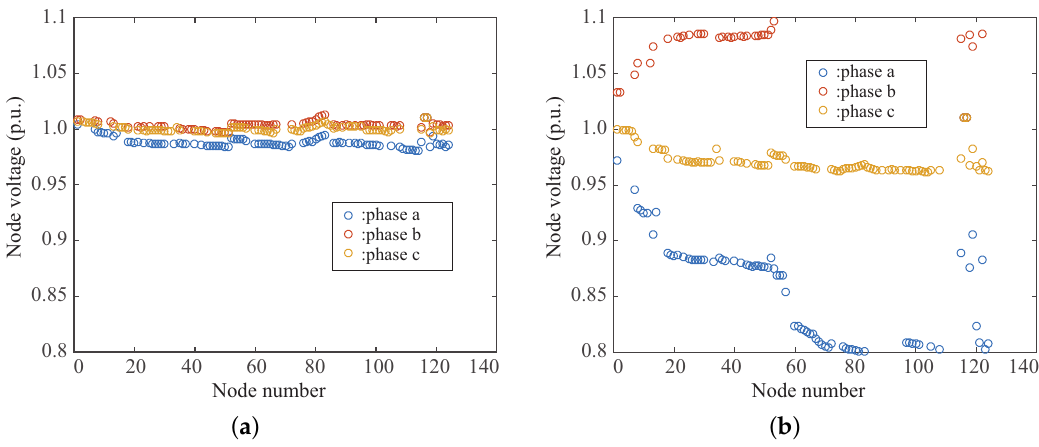
Figure 18. A comparison of MVUF : ( a ) initial state and ( b ) unbalanced